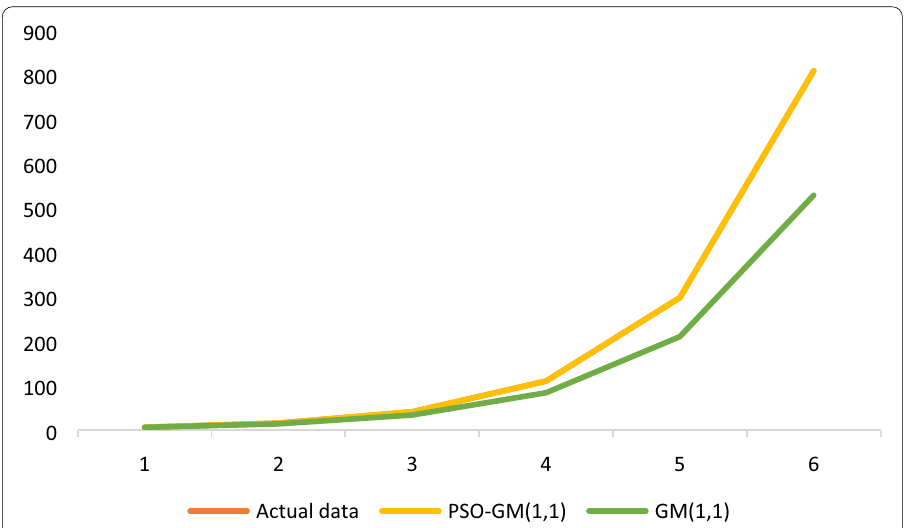
Fig. 2 Performance comparison of PSO-GM(1,1) and GM(1,1) for a monotonic increasing